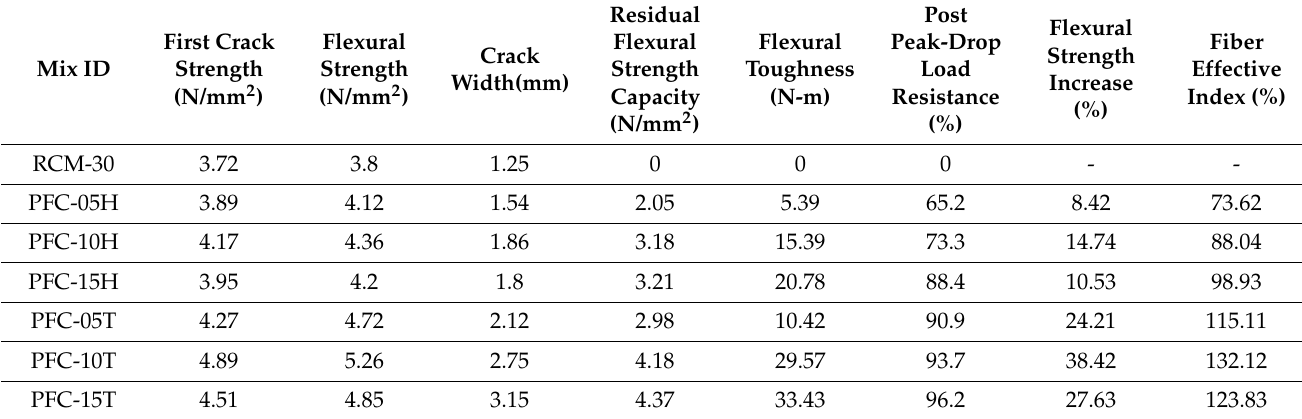
Table 7. Flexural evaluations of various plastic fiber incorporated concretes.